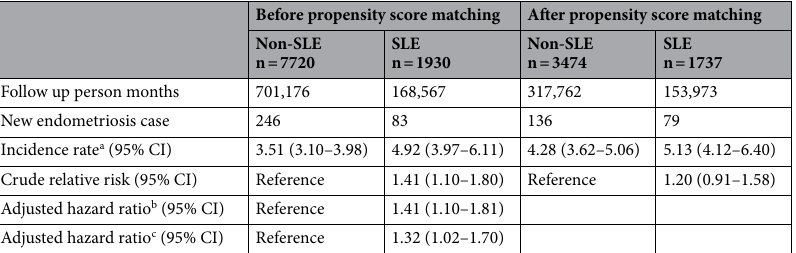
Table 2 . Incidence of endometriosis in study groups. a Incidence rate, per 10,000 person-months. b Multivariate Cox regression adjusted for baseline age, urbanization, and low income. c Multivariate Cox regression adjusted for baseline age, urbanization, low income, and